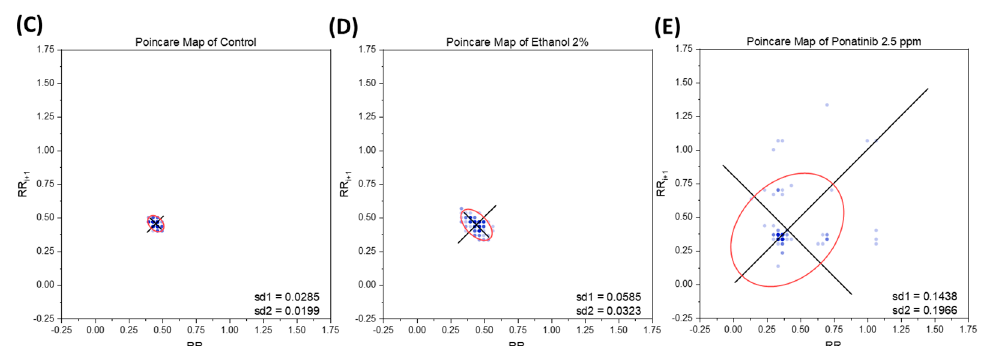
Figure 6. Heart rate variability evaluation in zebrafish embryos after exposure to ethanol 2% and ponatinib 2.5 ppm. Data analyses were conducted based on the standard deviation 1 (sd1) ( A ) and standard deviation 2 (sd2) ( B ) of the heart chamber generated by Poincaré Plot ( C – E ). The sd1 and sd2 results were statistically analyzed by Kruskal–Wallis test, followed by the uncorrected Dunn’s test. Data are expressed as mean ± SD, and statistical difference is indicated by **** p < 0.0001 ( n = 20).